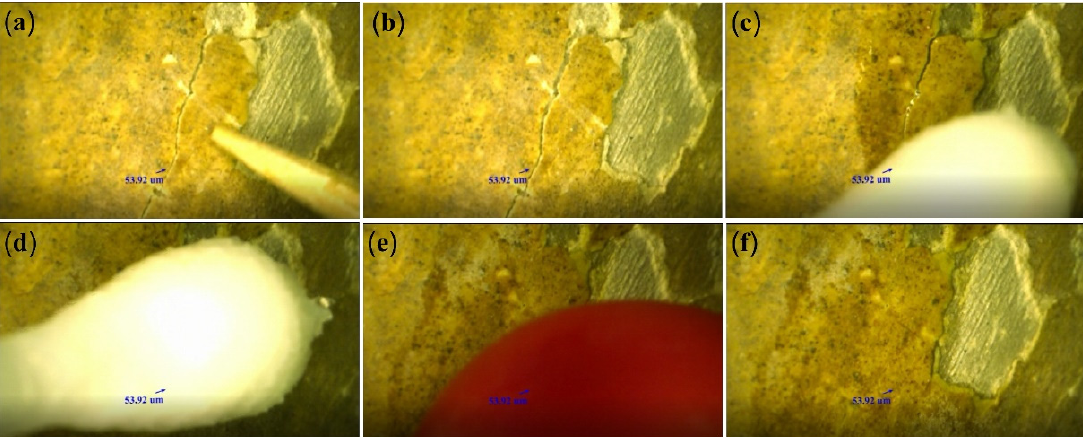
Figure 9. Restoration process of the micron ‐ level cracks. ( a ) Crack location, ( b ) crack measurement, ( c ) penetration of the adhesive agent, ( d ) air is removed from the cracks, ( e ) pressing and restoration, ( f ) after restoration.